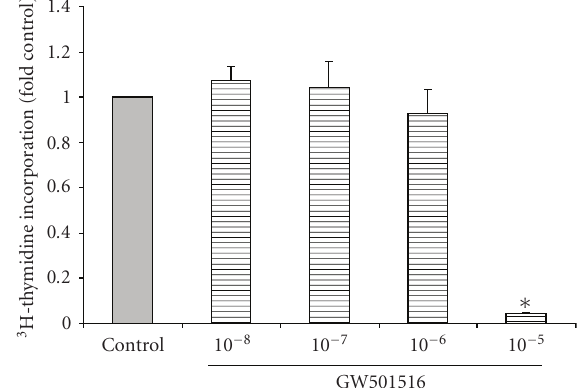
Figure 5: GW501516 causes a decrease in DNA synthesis at high doses. Serum-starved cells were stimulated for 24 hours with serum- free media (control) or increasing concentrations of GW501516 (10 − 8 to 10 − 5 M) 3 H-thymidine was added to IMCD-K2 cells while they were being stimulated and thymidine incorporation was measured in counts per minute using a scintillation counter, and expressed as fold control. Values are mean ± S.E.M.; n = 3. ∗ P < . 05 compared to